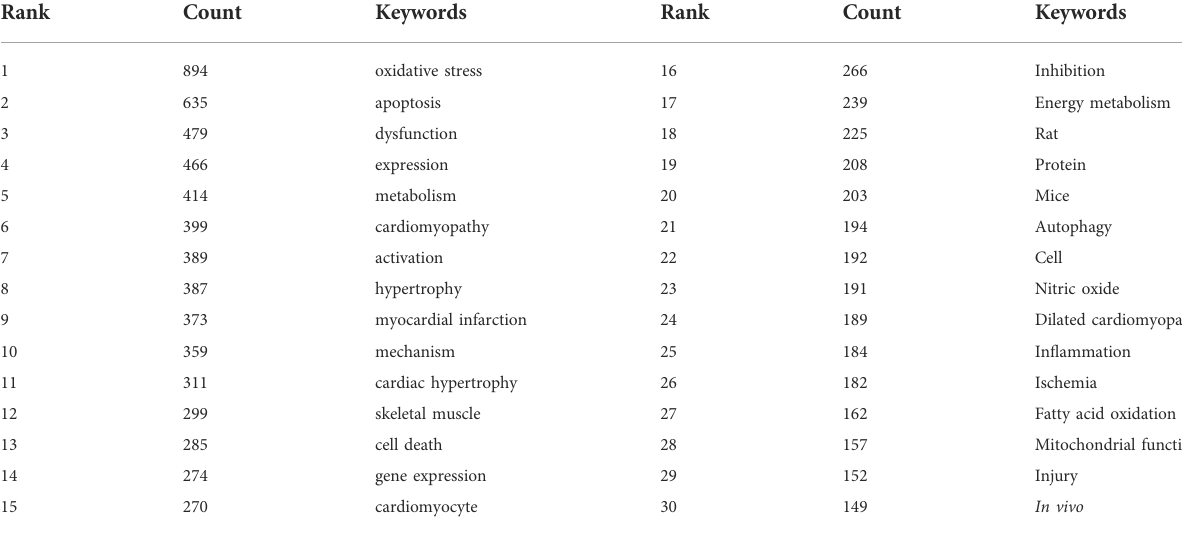
TABLE 6 Top 30 keywords related to mitochondrial function and heart failure. Rank Count